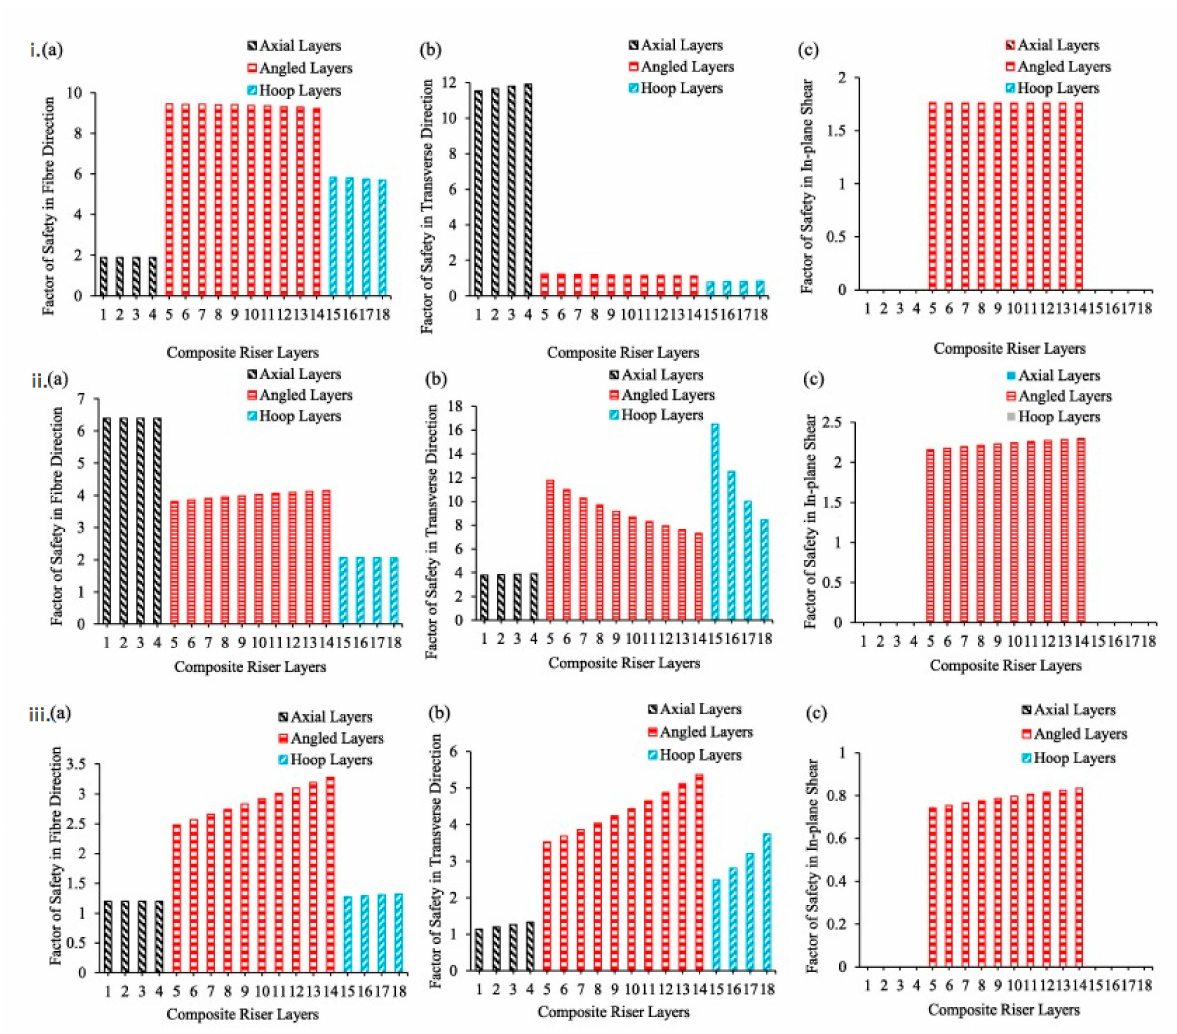
Figure 10. Composite riser with titanium as liners and configured utilising AS4/Epoxy for ( a ) fibre, ( b ) transverse and ( c ) in-plane shear directions, subjected to ( i ) pure tension, ( ii ) collapse loads and (iii) burst loads. The results were obtained from ANSYS ACP’s FEM. (Permission to reuse was obtained from Elsevier Publishers, Source: [149]; Published: 15 February 2019; Copyright date: